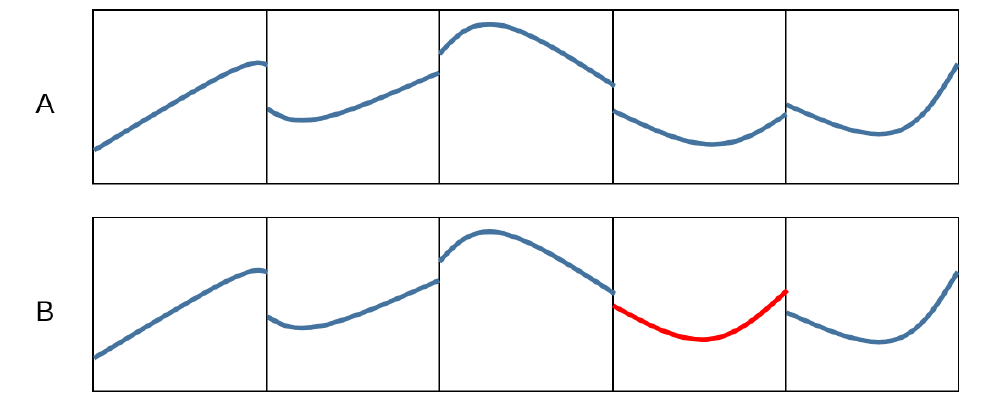
Figure 3. An illustration of the mutation methodology used, where ( A ) is the randomly selected candidate solution from the population and ( B ) is the randomly modified solution.